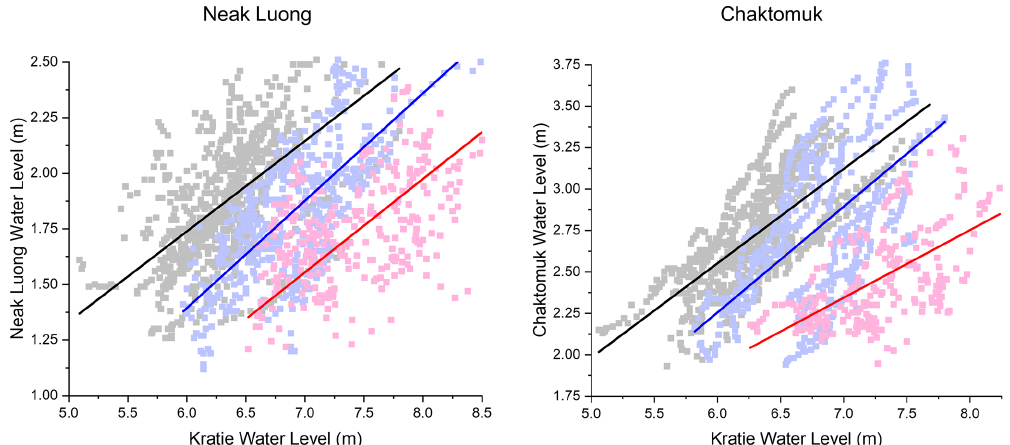
Figure 10. Comparison of water levels at Neak Luong/Chaktomuk against water levels at Kratie during February (black: 1960–1991; blue: 1992–2009; red: 2010–2019). Given the same water level at Kratie, the water levels at Neak Luong/Chaktomuk have been decreasing over